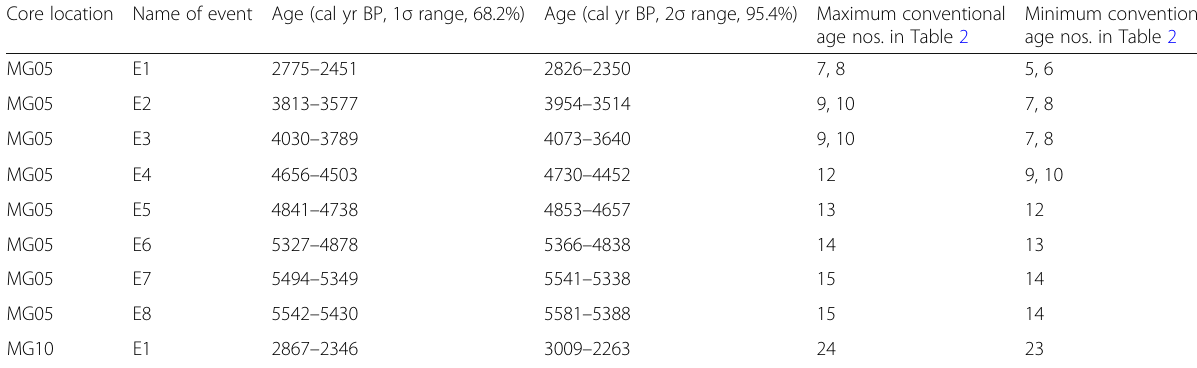
Table 3 Depositional ages of event deposits at